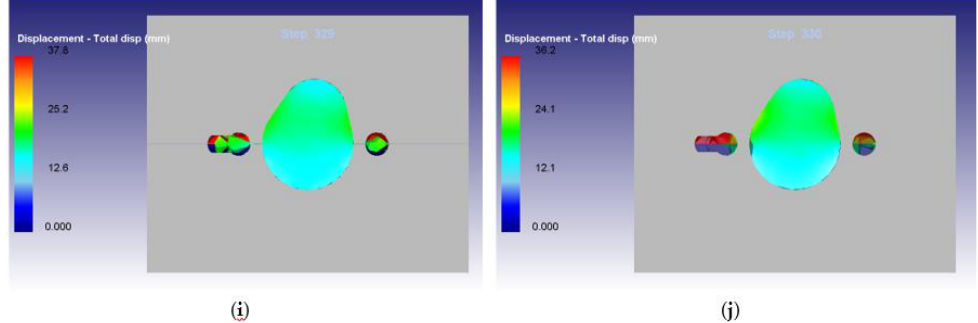
Figure 7. Cavity/undefiled volume in different cases studied. ( a ) Case I; ( b ) Case II; ( c ) Case III; ( d ) IV; ( e ) Case V; ( f ) Case VI; ( g ) Case VII; ( h ) Case VIII; ( i ) Case IX; ( j ) Case X.